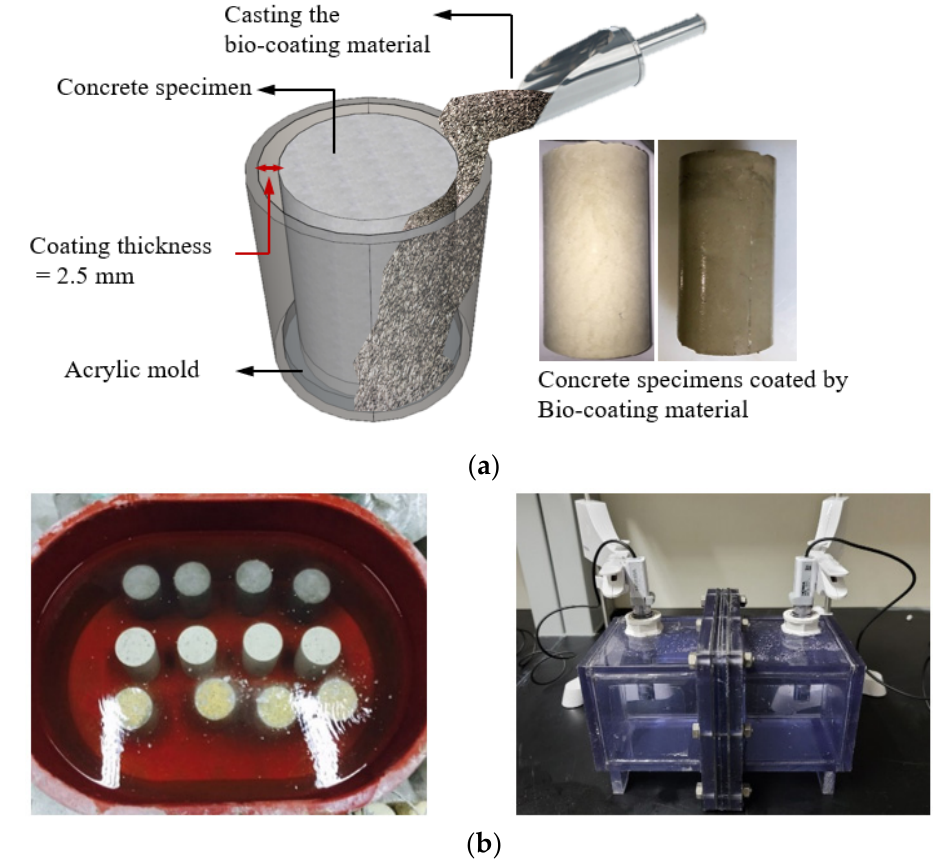
Figure 4. Photos of the resistance to sulfate ingress in bio-coating material with the negative pressure method: ( a ) preparation of the specimen coated with bio-coating material for the evaluation of the resistance to sulfate ingress; and ( b ) immersion in the sulfuric acid solution and sulfate ion diffusion coefficient.